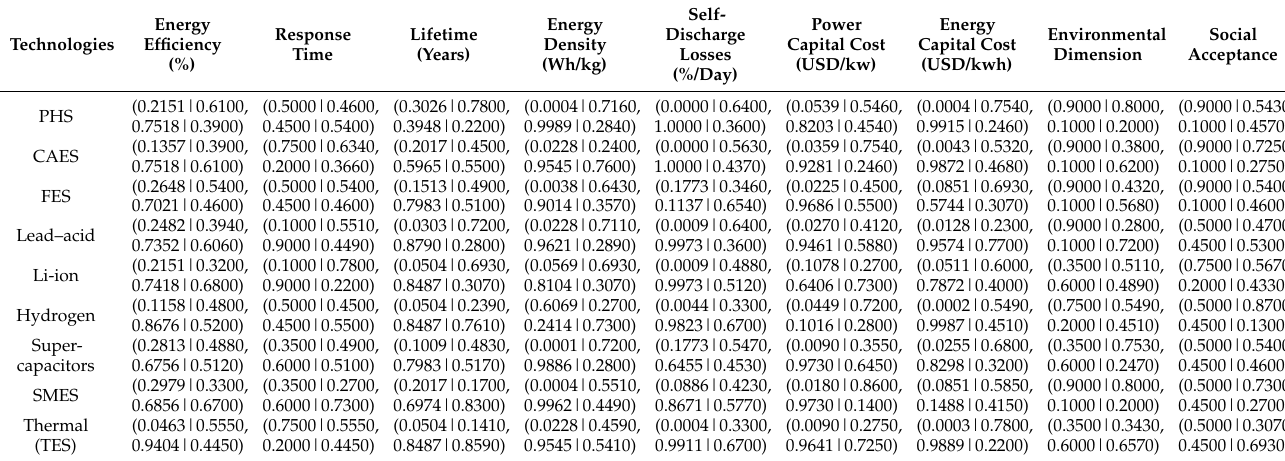
Table A14. Initial decision matrix of Expert 8.